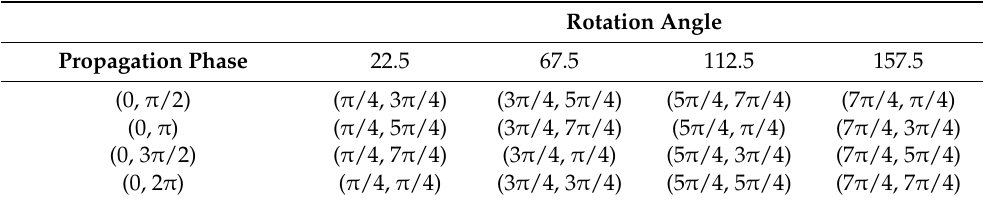
Table 1. The phase groups in 1/2 intensity.